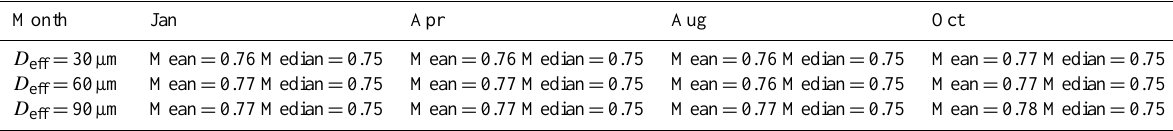
Table 2. Retrieved values of the asymmetry parameter g for all 4 months of data and three effective diameter sizes